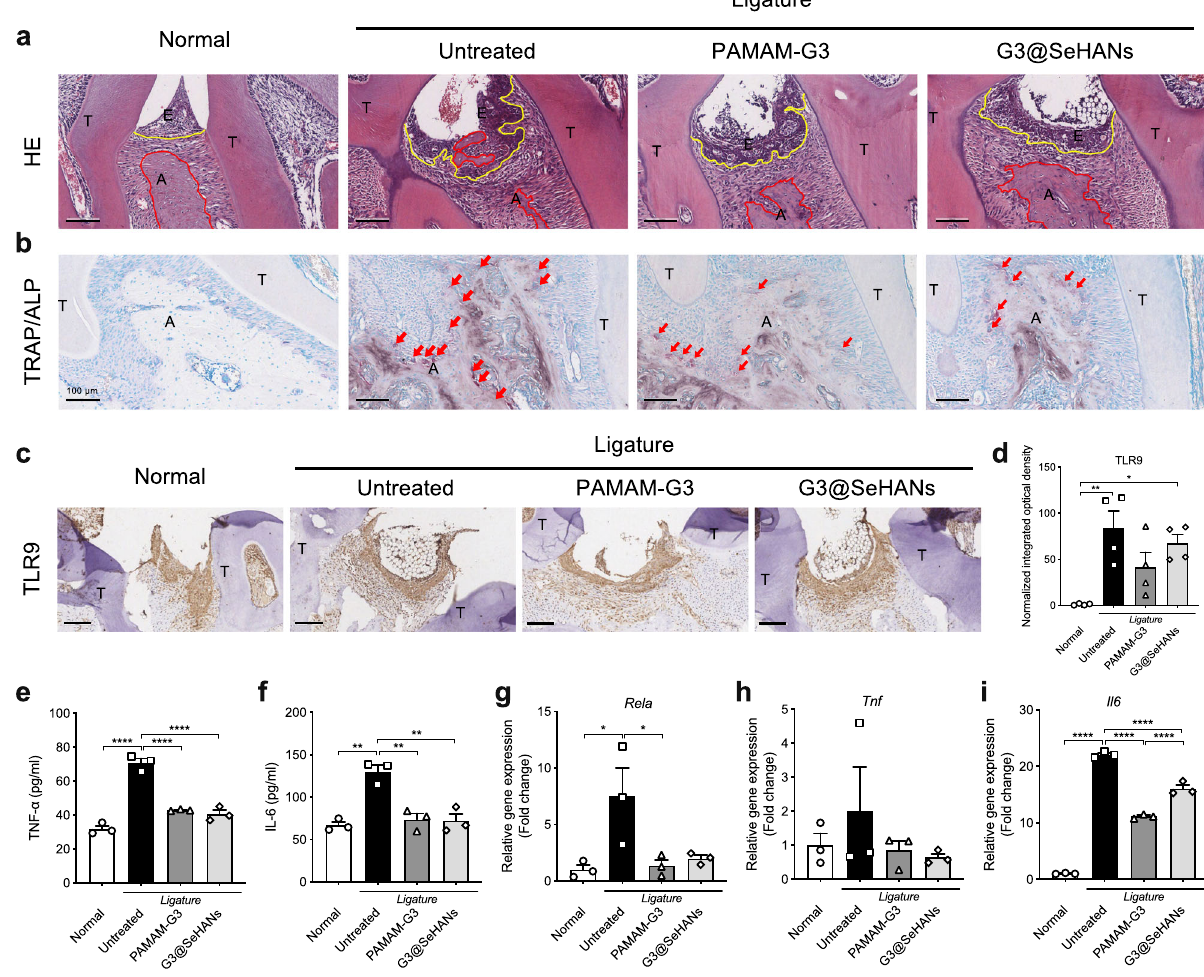
Fig. 6 | G3@SeHANs inhibit cellular proin fl ammatory response in ligature- induced periodontitis. a H&E staining of periodontal tissues on day 15 after G3@SeHAN administration. Scale bars, 100 μ m. In fl ammatory cell in fi ltration into theepitheliumandbonedestructionwereevidentintheuntreatedmodel,whereas G3@SeHAN treatment prevented these pathological changes. (E, epithelium; A, alveolar bone; T, tooth; yellow line indicates epithelial basement membrane; red line indicates alveolar bone crest). b TRAP/ALP staining of periodontal tissues on day 15 after G3@SeHAN administration. Scale bars, 100 μ m. The number of TRAP + osteoclasts (red arrows) in the untreated group was higher than in the DNA scavenger-treated groups. c IHC staining of TLR9 in periodontal tissues on day 15 after G3@SeHAN administration. Scale bars, 100 μ m. TLR9 expression increased signi fi cantly in the untreated group; treatment with G3@SeHAN or PAMAM-G3 reduced TLR9 expression. Images ( a – c ) were representative of three independent mice. d Expression of TLR9 in the epithelium of periodontal tissues. Data